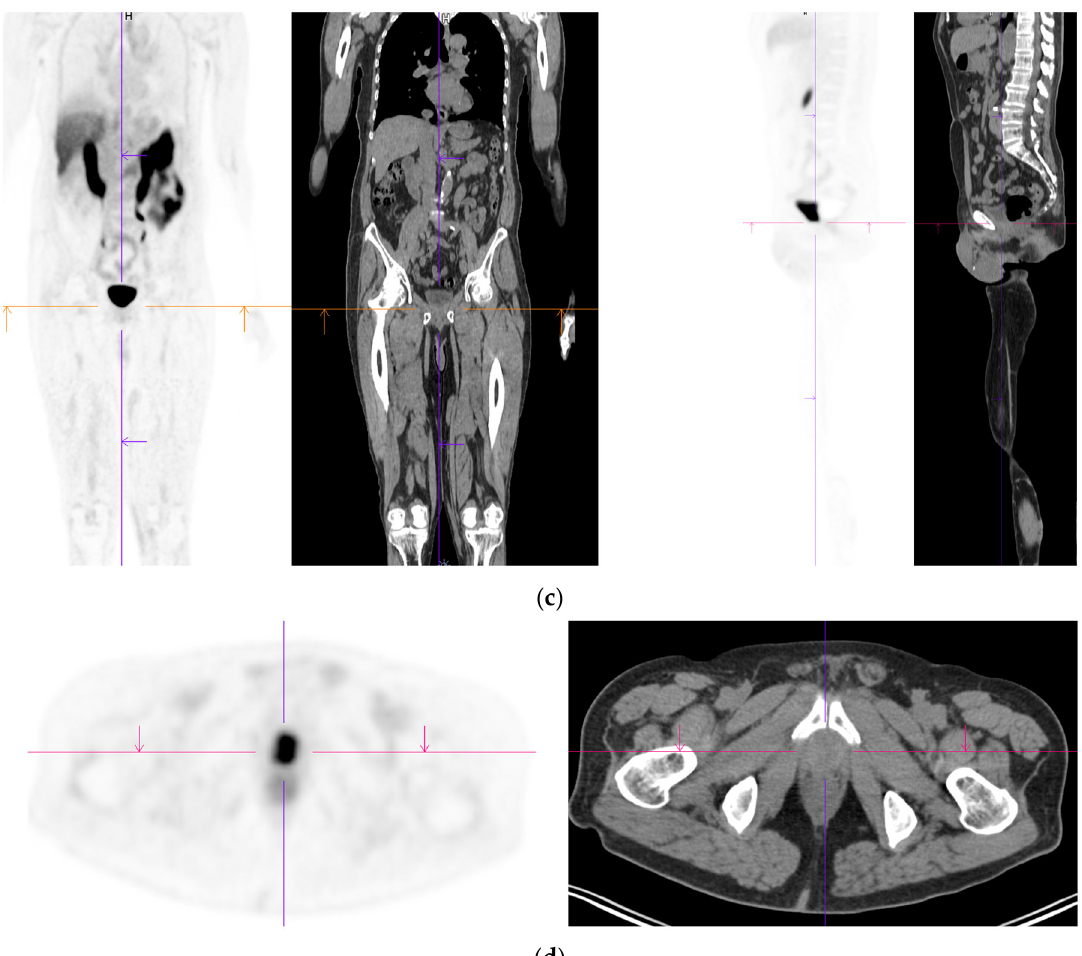
Figure 5. Biochemical recurrence—negative scan; normal distribution of tracer. 75 yr old M—radical prostatectomy 7 yrs prior; PSA 0.42. PSMA PET-CT: 68 Ga-PSMA - 219 MBq; uptake 48 min; BMI = 22.6; Wt 63 kg. ( a , b ): coronal images show physiological uptake in parotid glands, bowel and kidneys and tracer pooling in bladder; X-hairs show uptake in cervical (SUV = 2.3) and sacral (SUV = 2.5) nerve roots and sympathetic ganglia in upper abdomen SUV = 4.6. ( c , d ): enlarged coronal, sagittal and transaxial images of prostate bed; X-hairs identify locations; no abnormal tracer uptake but pooling of trace in bladder problematic; Note—scale in sagittal images on ( c ) has been deliberately altered to ensure there are no adjacent focal regions of uptake to suggest local tumor recurrence.